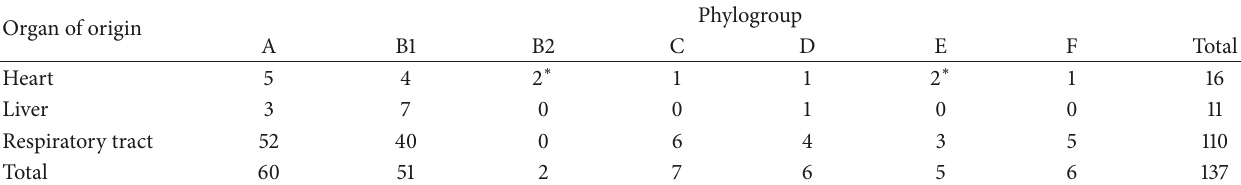
Table 3: Distribution of phylogroups of E. coli strains isolated from the heart, liver, and respiratory tract of broiler during inspection. Organ of